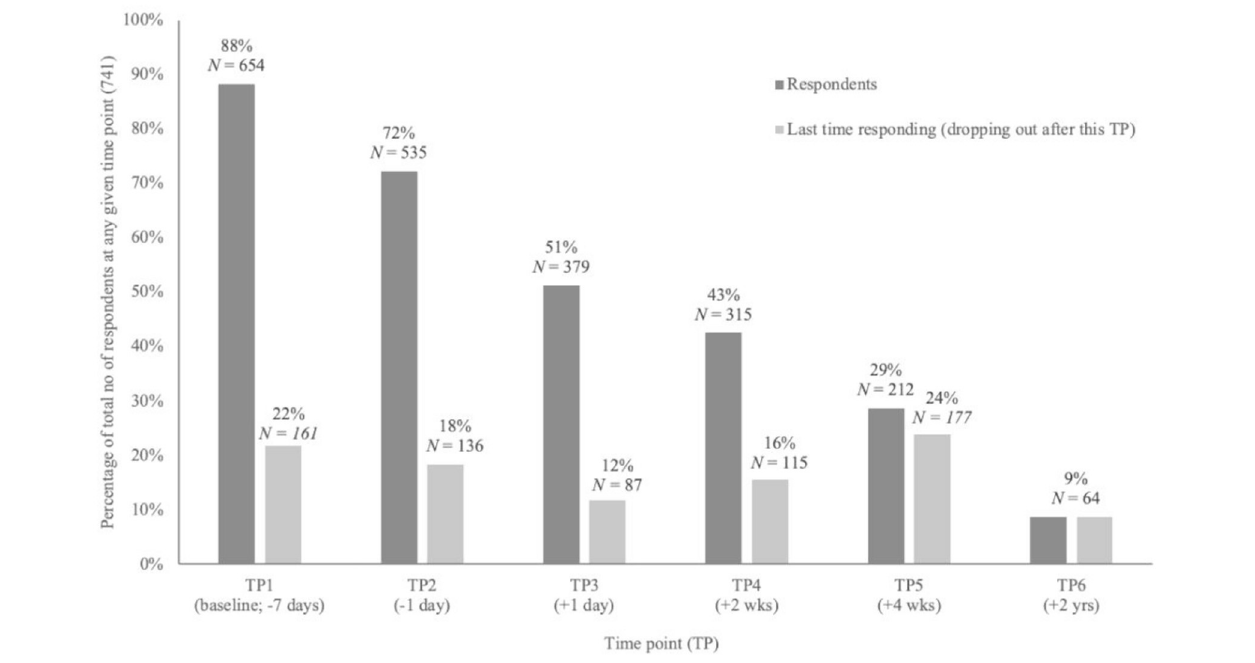
FIGURE 4 | Attrition. Per time point the sample size and number of respondents who did not complete any more surveys after this particular time point (dropping